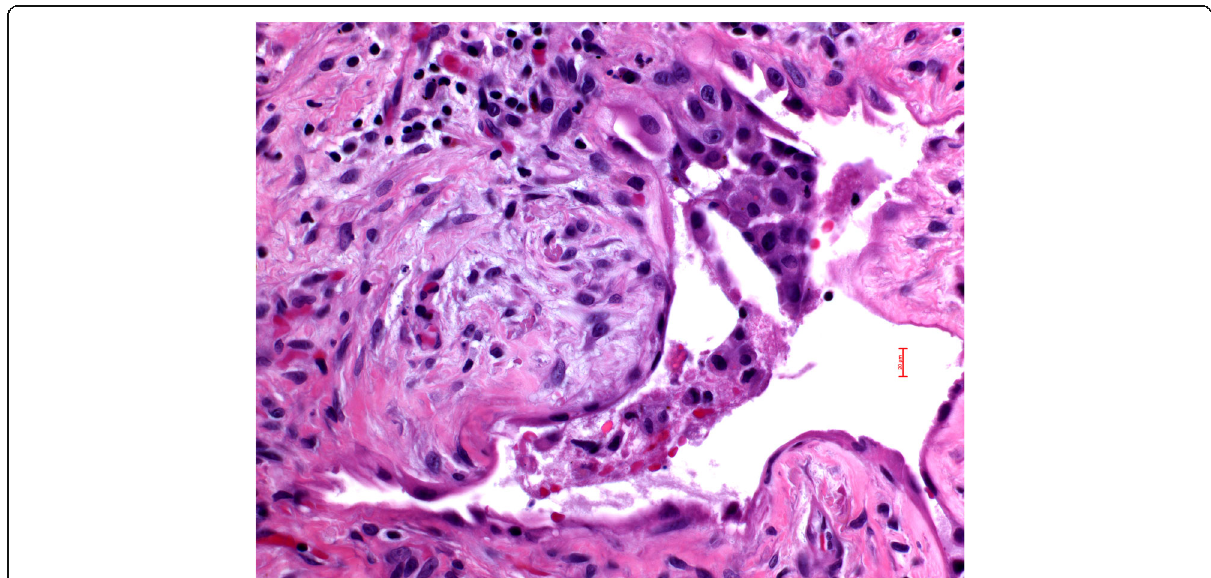
Fig. 6 Myofibroblastic focus with apoptosis of the pneumocytes; there is also a tiny focus where the surface is denuded. H&E, bar 20 μ m